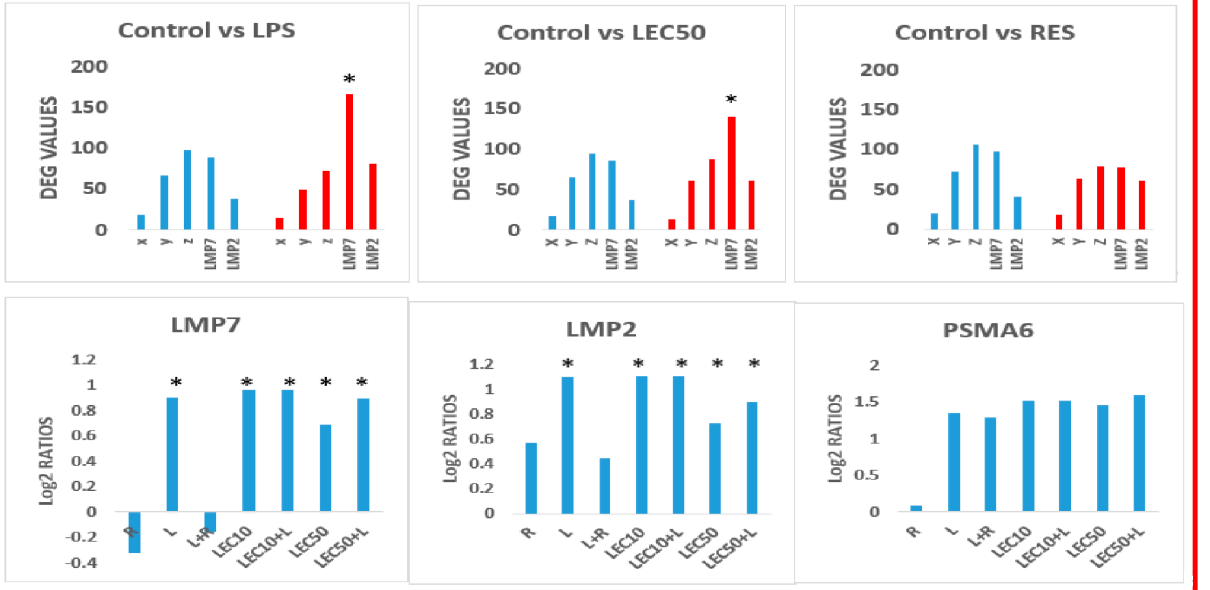
Figure 4. Functions of various components on gene expression of proteasome subunits. Human PBMCs were treated with three compounds and the vehicle control for 3 h as described in legend to Figure 1. These data were first extracted using the DEG analysis and plotted. The top row indicated the log2 ratios for control groups, and bottom row showed the log2 ratios for LMP7, LMP2 and PSMA6 (another proteasome subunit that was not downregulated by RES but was upregulated by LPS) with the different treatments (RES, LPS, RES + LPS, LEC10, LEC10 + LPS, LEC50 and LEC50 + LPS) were calculated relative to the control. p values were < 0.05. * significant gene expression.